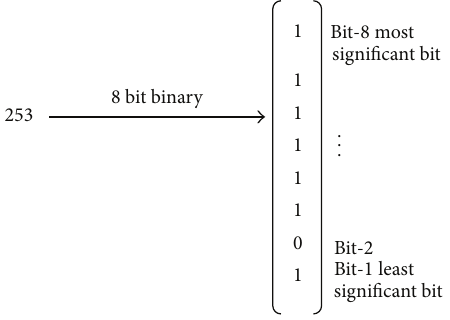
The first level started with segmentation of the images into various bit planes starting from the least significant bit (LSB) to the most significant bit (MSB). The intensity value of each pixel was denoted by an 8-bit binary vector and the value was either 0 or 1 as shown in Figure 1. Thus, each bit plane was represented by a binary matrix which was further used to generate image slices for respective bit planes as in Figure